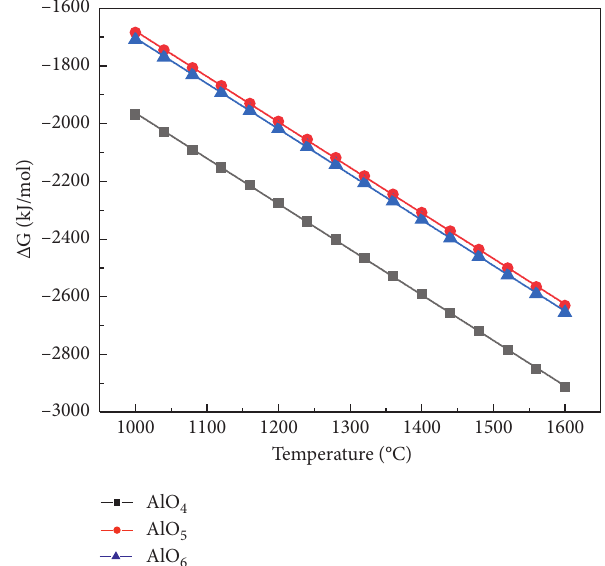
Figure 4: Change in ∆ G of different structures with respect to temperature.